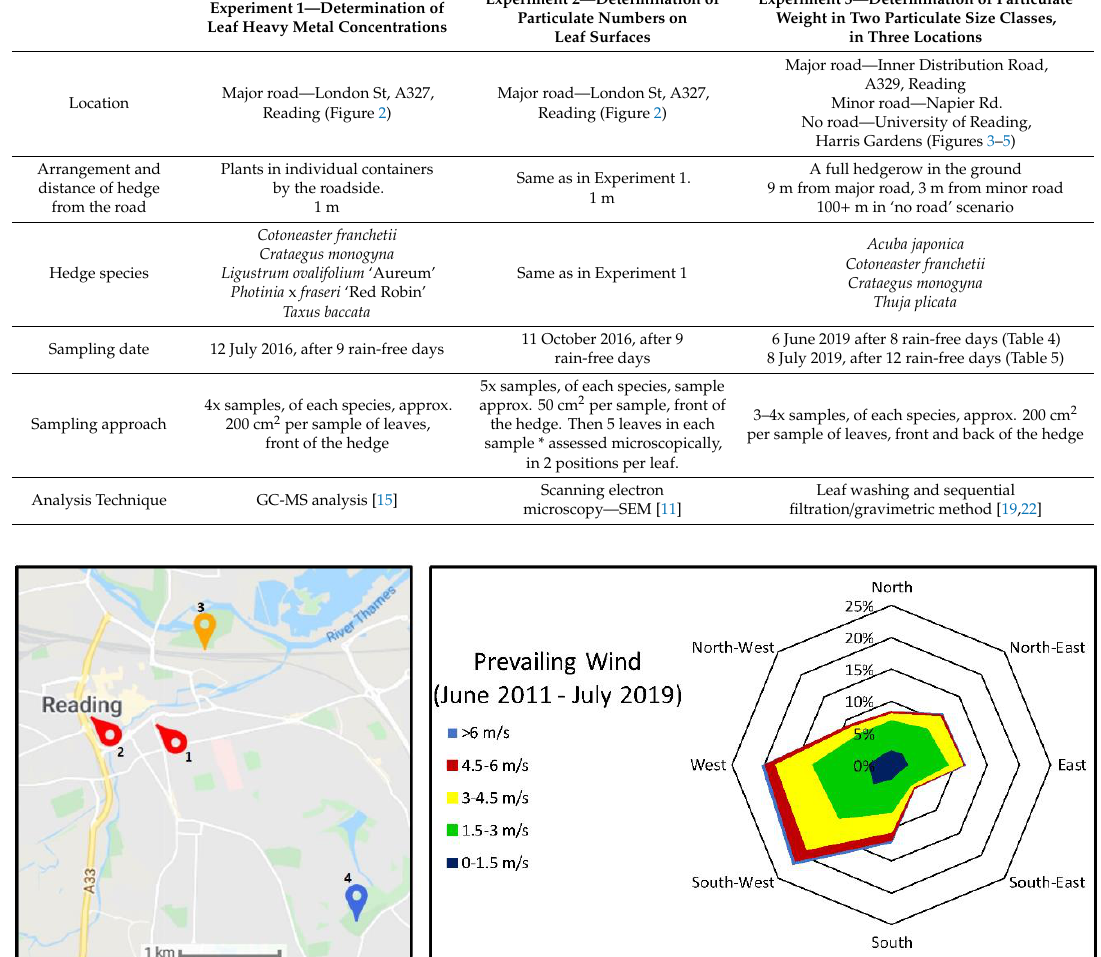
Figure 1. Location of sampling sites within central Reading (UK): Red 1 & 2—major roads, Orange 3—minor road, Blue 4—Harris Garden (control), and corresponding wind rose indicating prevailing wind conditions.